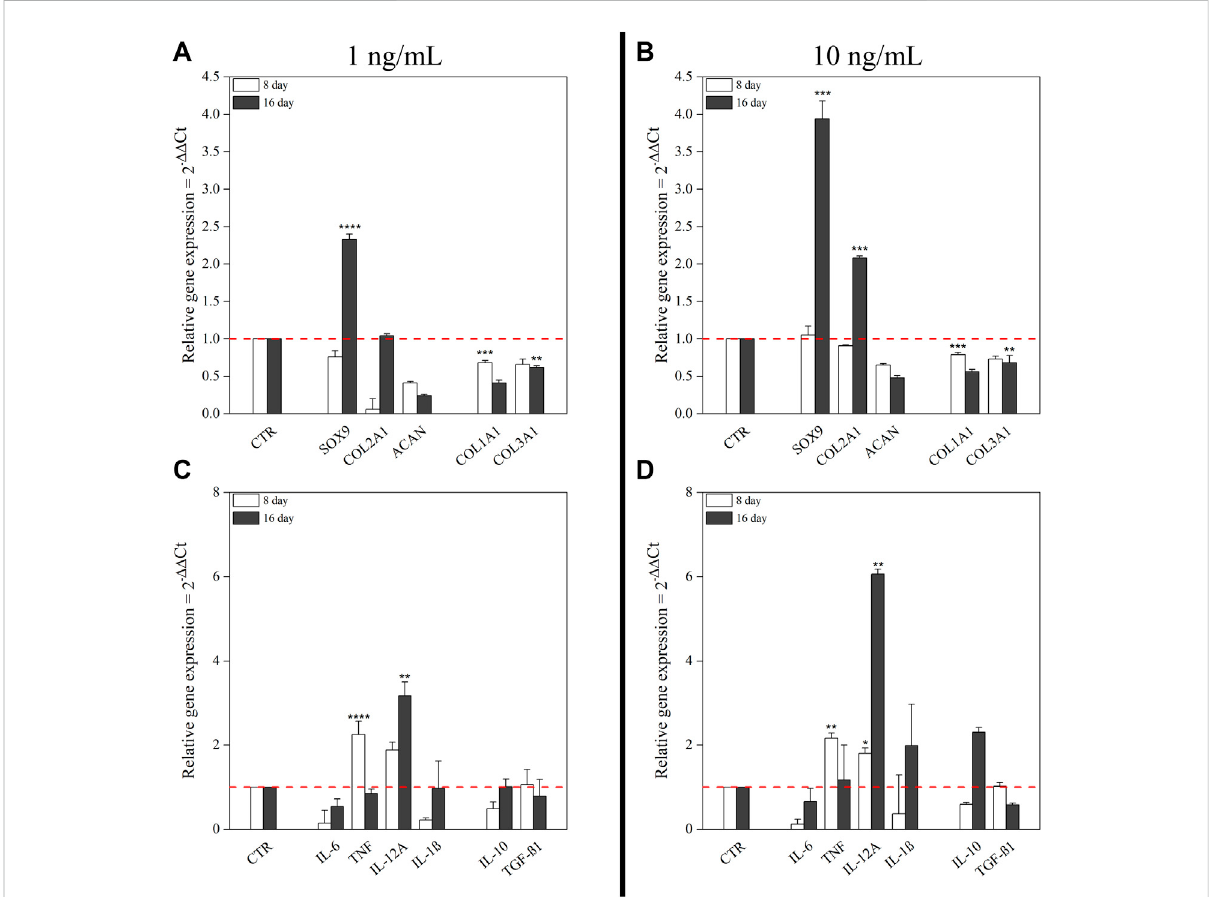
FIGURE 1 Effect of hTGF- β 1 on the expression of chondrogenic markers and cytokines by hBM-MSC monolayer. Two different concentrations of hTGF- β 1 (1 ng/ml and 10 ng/ml) for up to 16 days were tested. Untreated cells at matched time points were used as control. mRNA expression levels of positive and negative chondrogenic markers ( COL1A1 , COL2A1 , COL3A1 , SOX9 , and ACAN ) at 1 ng/ml (A) and at 10 ng/ml (B) ; pro- and anti- in fl ammatory cytokines ( IL-6 , TNF- α , IL-12A , IL-1 β , IL-10 , and TGF- β 1 ) at 1 ng/ml (C) and at 10 ng/ml (D) . All data were analyzed by two-way ANOVA, N = 3 (biological replicates); * p < 0.05, ** p < 0.01, *** p < 0.001, and **** p < 0.0001 vs.